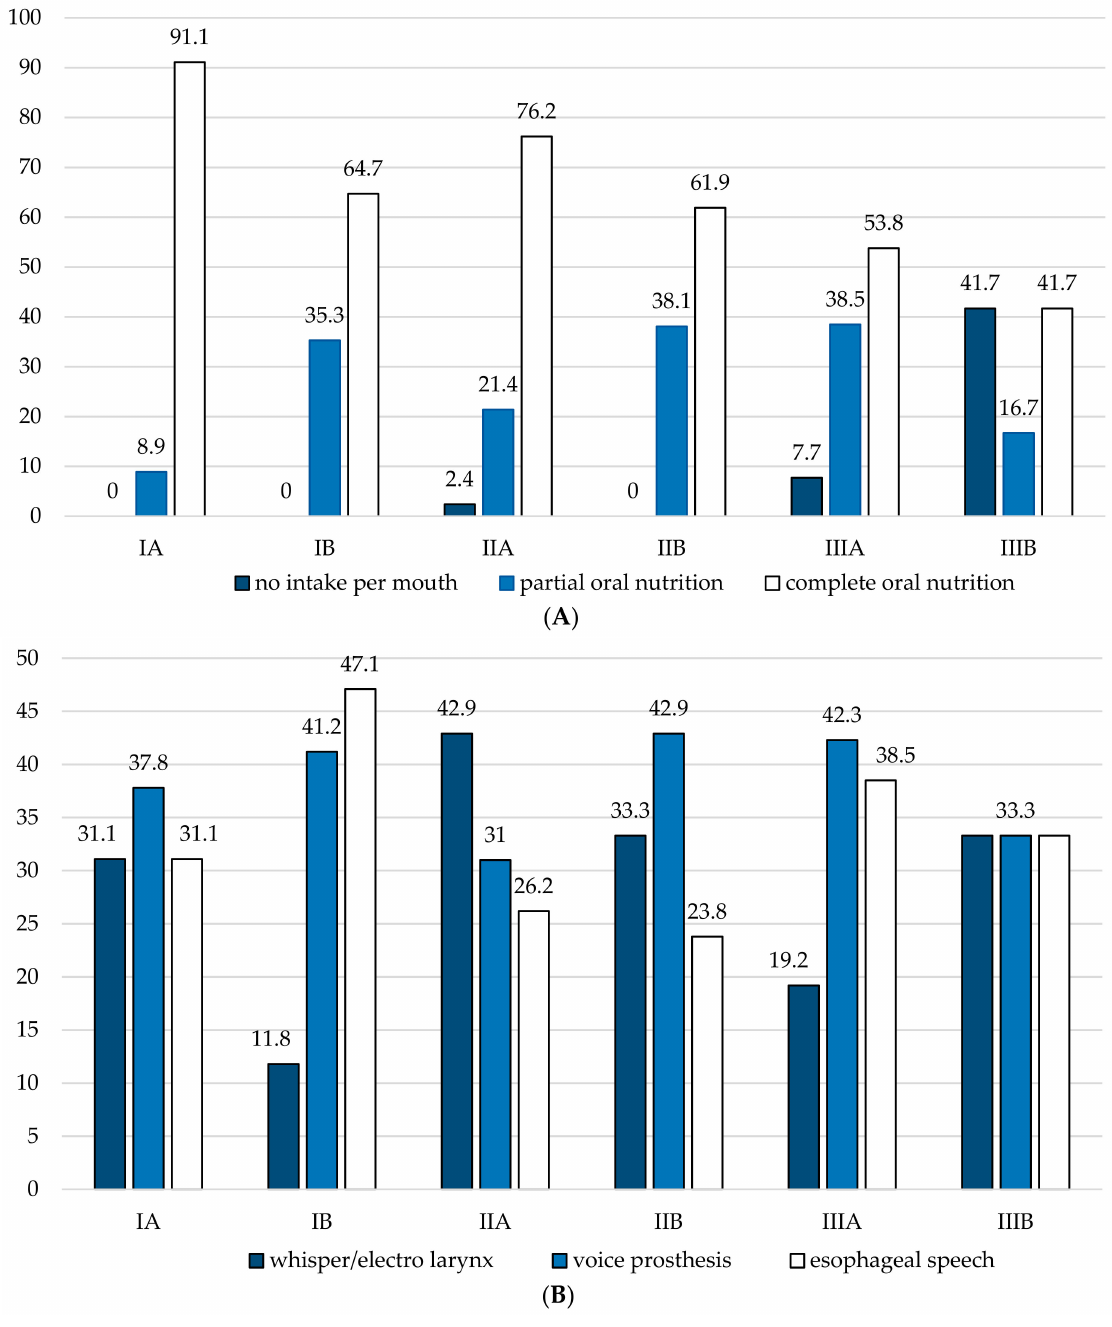
Figure 5. Functional outcomes according to the Vienna Laryngopharyngectomy Classification system. Charts showing functional outcomes for ( A ) oral nutrition ( p < 0.0001) and ( B ) voice rehabilitation ( p = 0.573) depending on the extent of ablative surgery (I: laryngectomy; II: laryngectomy with partial pharyngectomy; III: laryngectomy with total pharyngectomy) and whether each surgery was performed in salvage situation (A: non-salvage; B: salvage). Values are given in